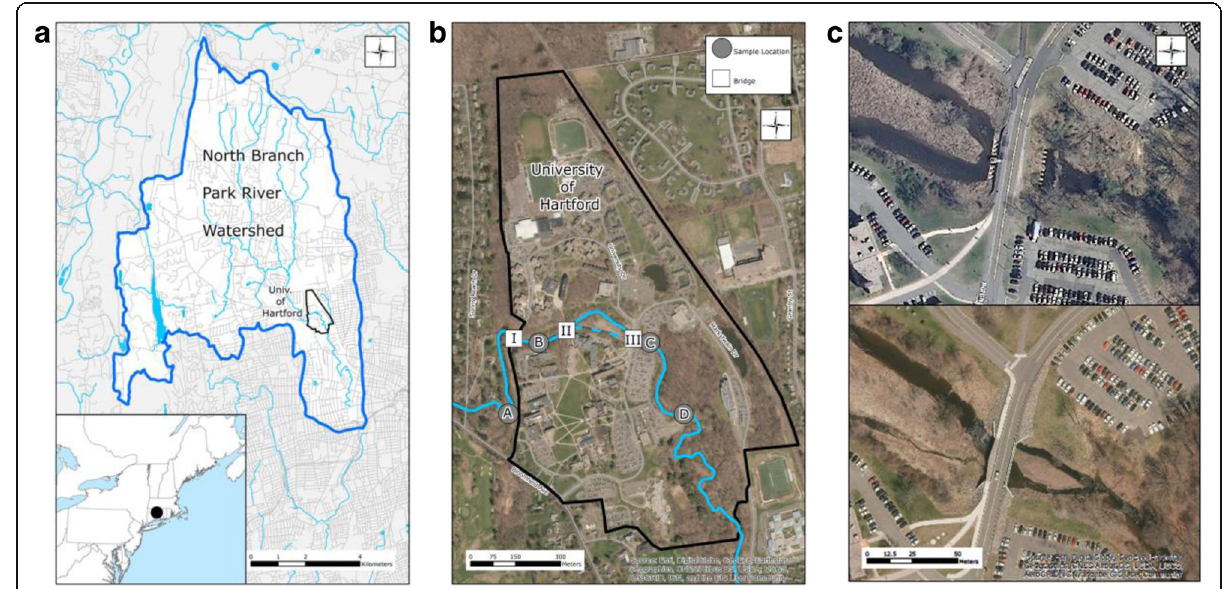
Fig. 1 a Location of the North Branch Park River watershed in Connecticut, USA. b Location of the four sampling sites. Sites A and B were located upstream of the construction site, and sites C and D were downstream of the construction site. Stream crossing I is a concrete single-span road bridge, stream crossing II is a pedestrian truss bridge, and stream crossing III is the new concrete single-span road bridge. The dashed line represents a stream channel that only conducts water during high flow; only the northern channel conducts water during normal flow. c Satellite view of the previous structure (embankment with culverts) in March 2012 (top) and the new structure (bridge) after it was completed in February 2013